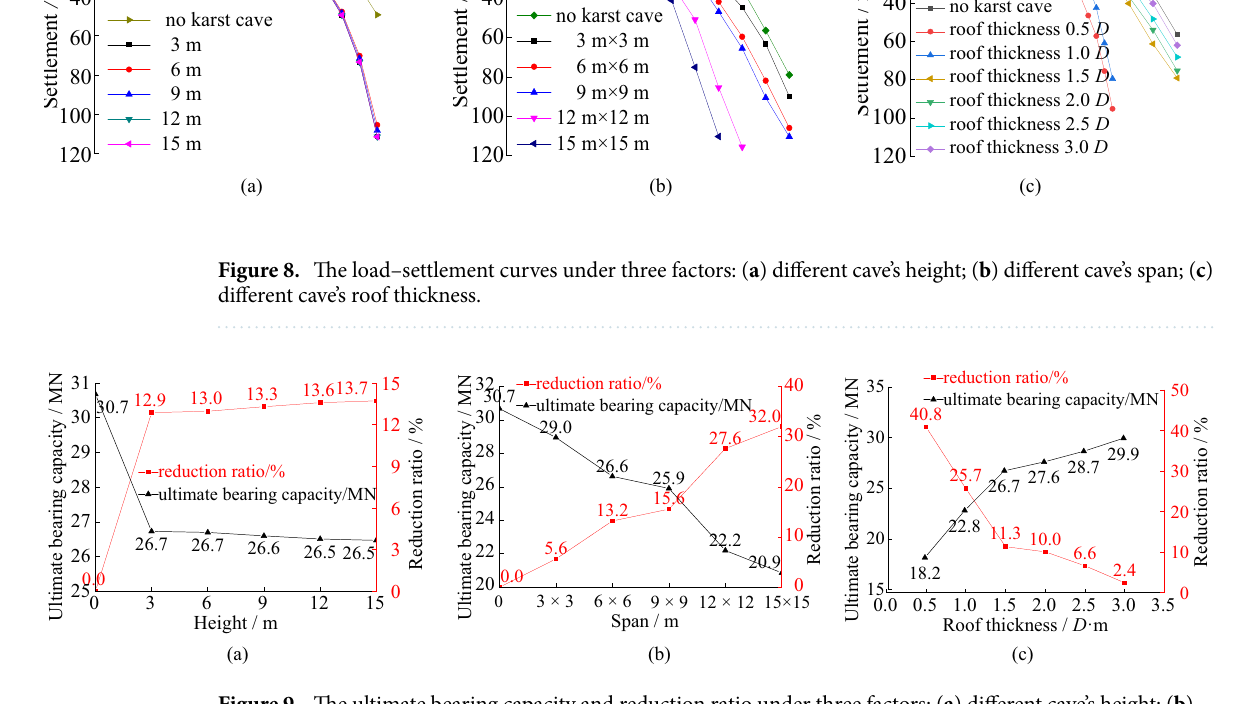
Figure 9. The ultimate bearing capacity and reduction ratio under three factors: ( a ) different cave’s height; ( b ) different cave’s span; ( c ) different cave’s roof